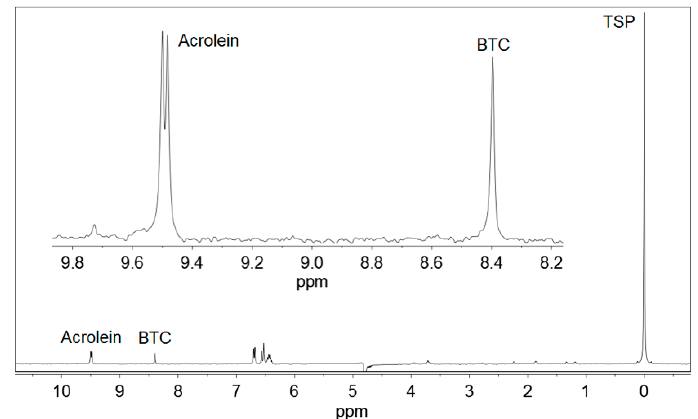
Figure 1. 1 H NMR spectrum of a standard for calibration containing 35.1 mg/L acrolein, 1,3,5-benzenetricarboxylic acid (BTC) and 3-(trimethylsilyl)-2,2,3,3-tetradeuteropropionic acid sodium salt (TSP). An expansion of the working region is shown.